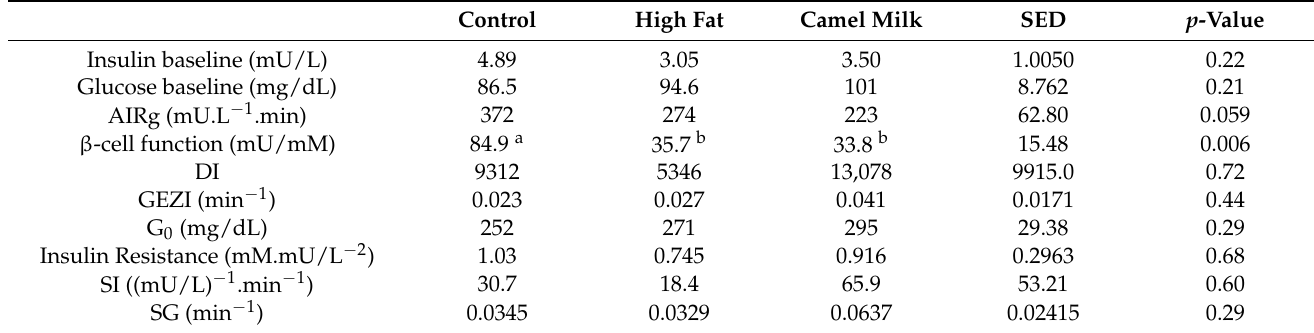
concentration at time 0; SI = insulin sensitivity; SG = glucose